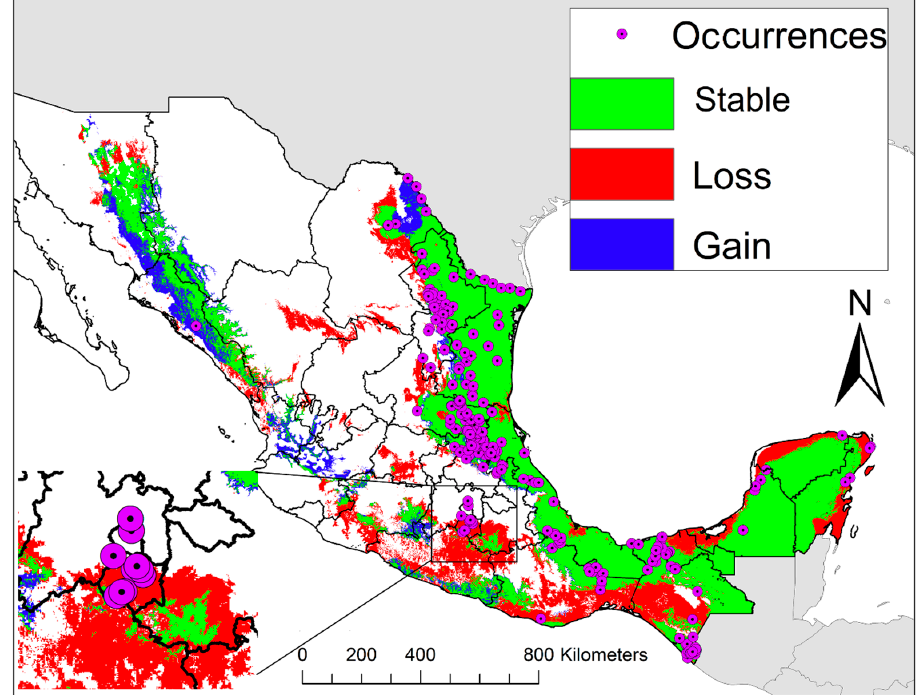
Figure 5. Comparisons of ecological niche models of Aedes albopictus in México. The relationships between the Pech-May et al. [9] ecological niche model and the 2020 ecological niche model. The green areas represent the areas where congruent predictions occurred between the two models, the red color represents the areas where Aedes albopictus is anticipated to occur by the Pech-May et al. [9] ENM only, and blue color represents the areas where Ae. albopictus is anticipated by the 2020 ENM only. The square at the bottom left corner of the map presents a close-up map showing the relationship between some of 2015-2020 occurrences and the Pech-May et al. [9] prediction.